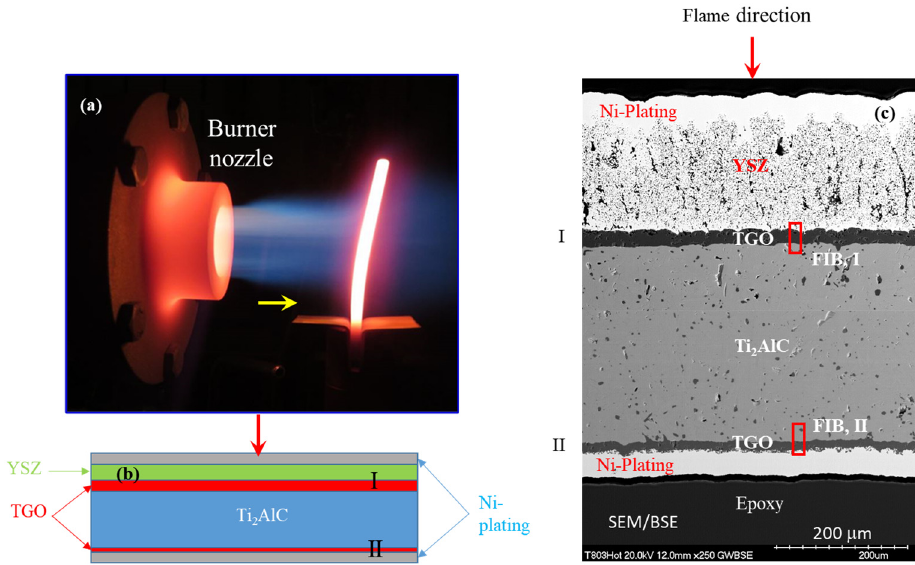
Figure 2. Orientation of FIB samples at (I) front and (II) back sides of the sample. ( a ) Photograph of burner operation showing front side flame impingement. ( b ) Schematic of sample cross-section. ( c ) Montage of SEM/BSE cross-section images of the sample and scale showing the TBC-coated front side (I) and bare backside (II) after 500 h burner rig test at 1300 °C.